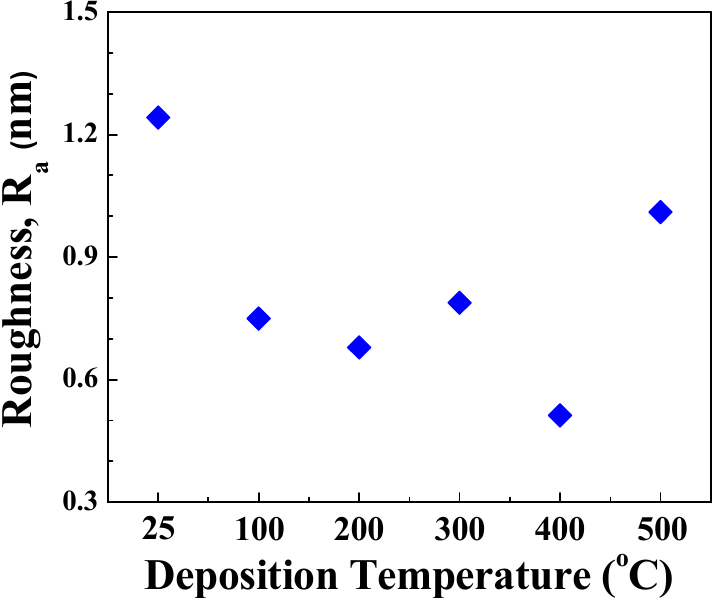
Figure 4. Variation of surface roughness of Mo films with deposition temperature.